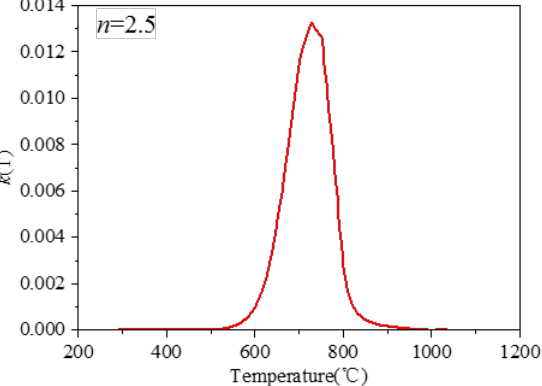
Figure 8. Kinetic parameters β α k → of Ti-6Al-4V diffusion-controlled transition.